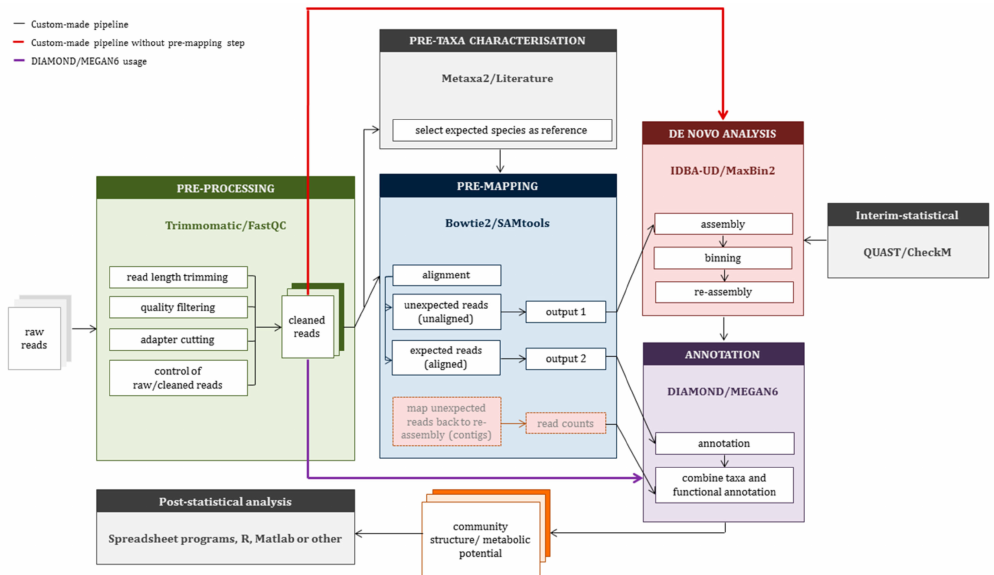
Figure 1. Metagenomic analysis by using MEGAN6 stand-alone or a custom-made pipeline approach. Custom-made pipeline to analyze metagenomic data by using prior information on expected microbial species (black arrows). Alternatively, the pre-mapping step can be skipped and de novo assembly (red arrow) or annotation by using MEGAN6 (purple arrow) be done directly using cleaned